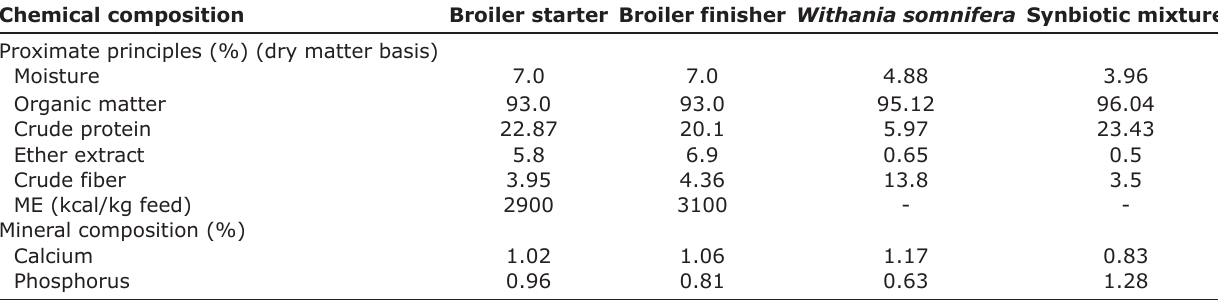
Table-1: Proximate analysis 1 of broiler feed, Withania somnifera and synbiotic substances. Chemical